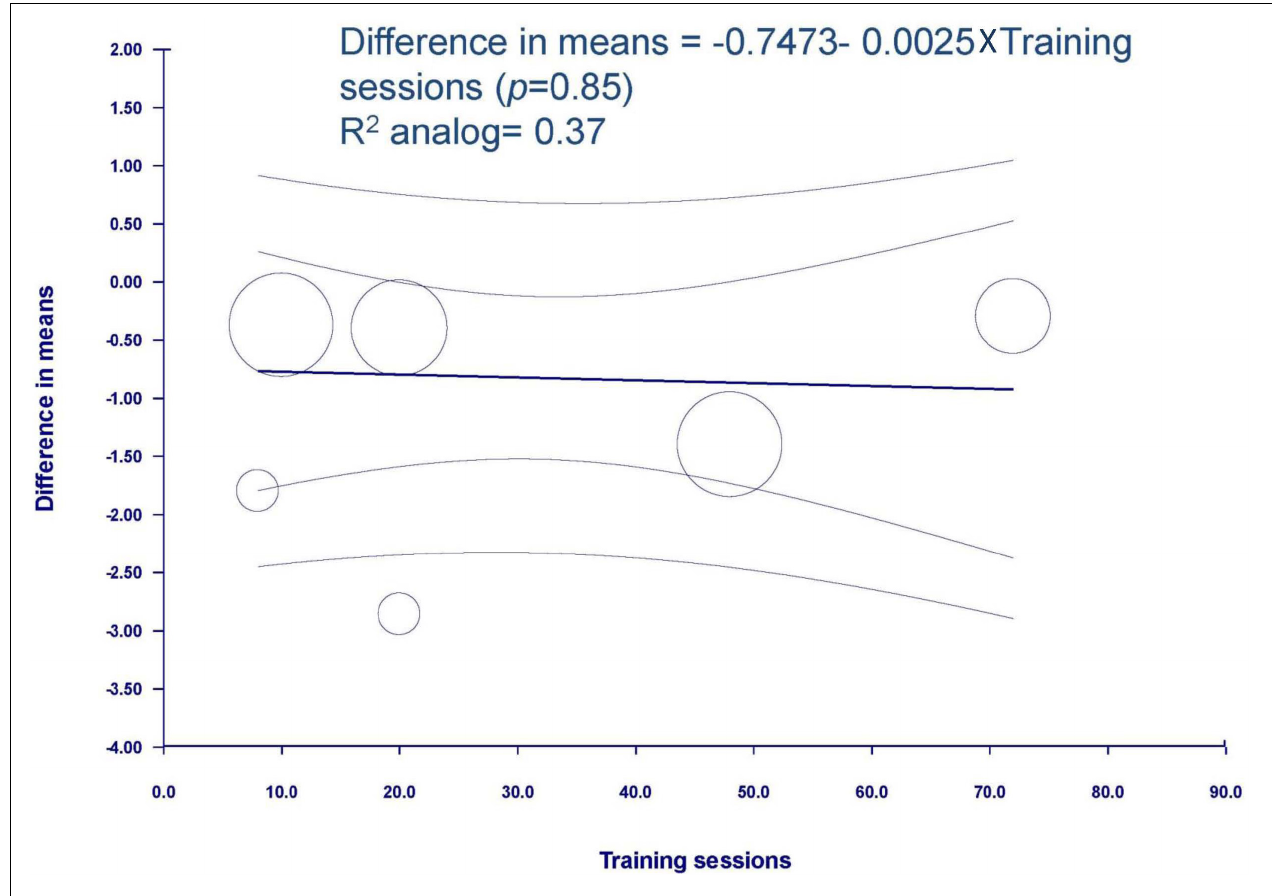
FIGURE 5 | Meta-regression of spasticity on training sessions. Regression line and 95% CI were presented.